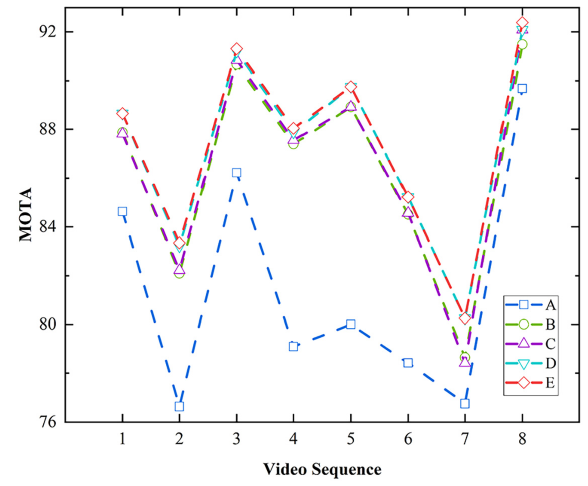
Figure 18. The tracking effect of each test video.